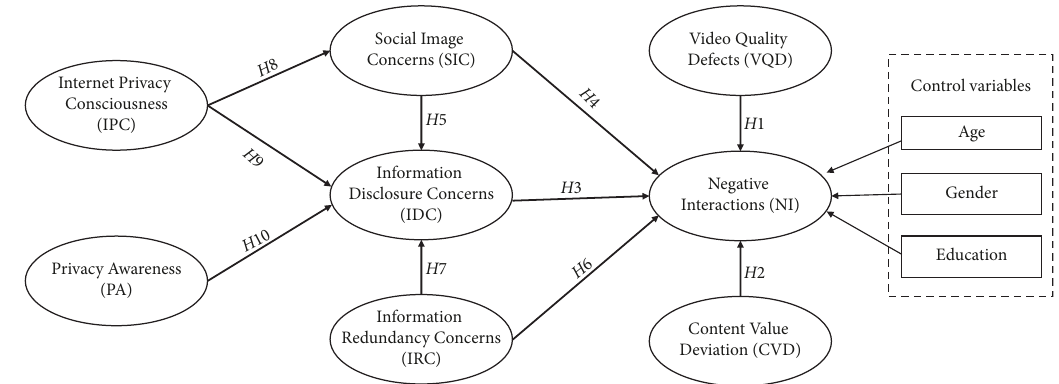
Figure 1: Te theoretical model of impact factors for TikTok users’ negative